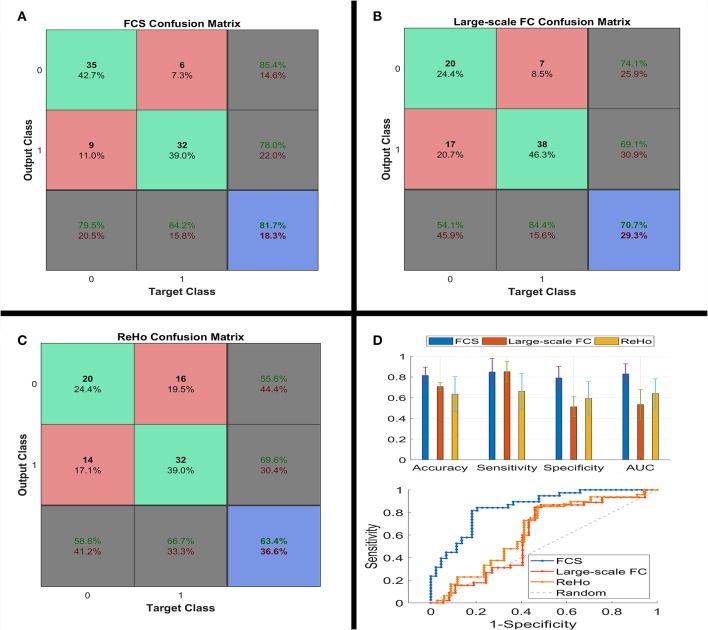
Confusion matrix (A–C), classification performances (the upper part of D) and ROC (the lower part of D) of linear SVM classifier using the three types of the functional connectivity features. ROC, receiver operating characteristic; SVM, support vector machine.